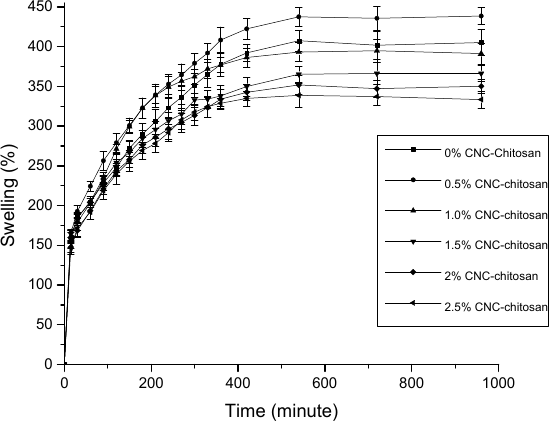
Figure 4. Equilibrium swelling ratio of hydrogels with varying CNC.